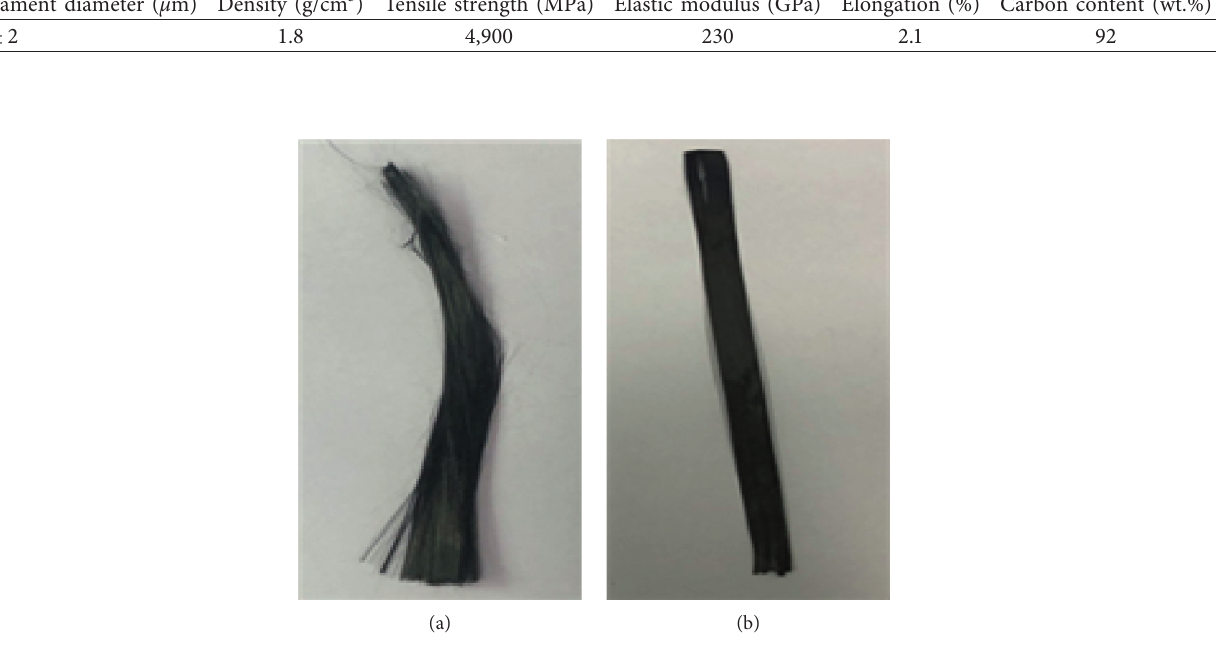
Figure 5: Carbon fibers used in the experiment. (a) Nano-SiO 2 -coated carbon fiber. (b) Plain carbon fiber. Table 3: Description of fabrication of specimens for the pull-out